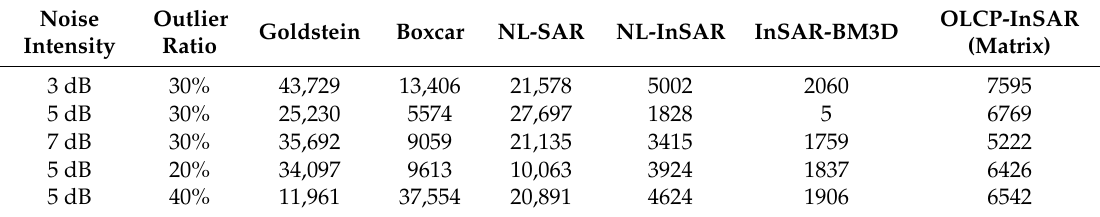
Table 4. The number of residues remaining in a filtered interferogram with di ff erent noise